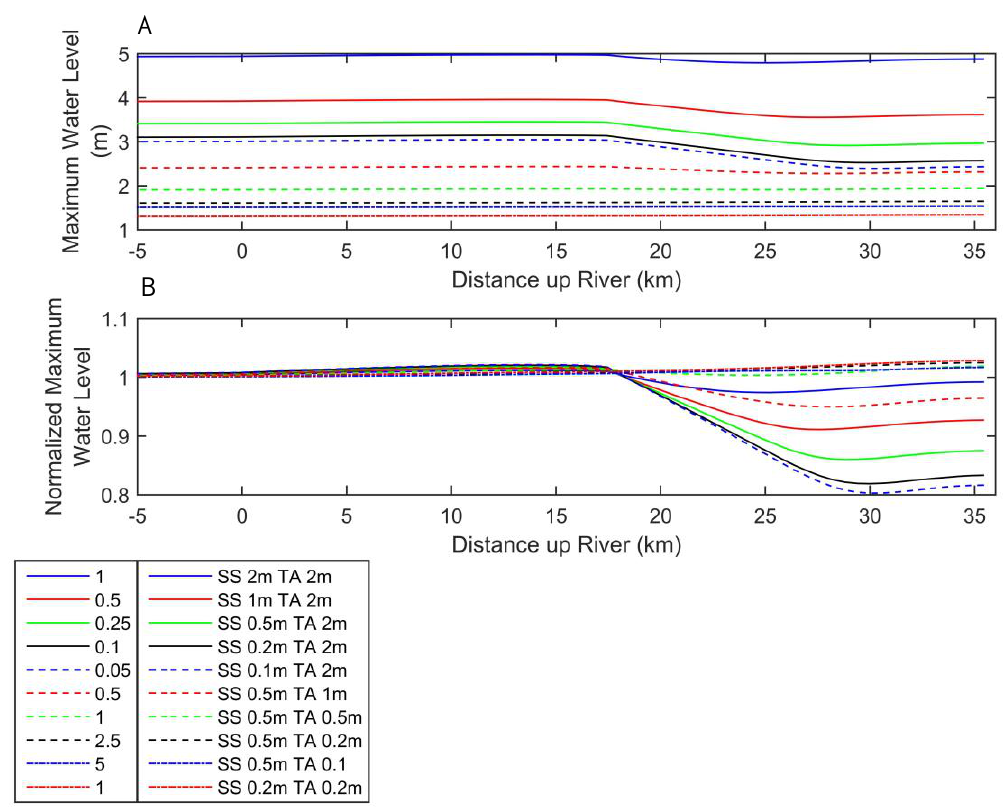
Figure 7. ( A ) Maximum water levels along the idealized river with varying storm surge (SS) and tidal amplitude (TA). The value for each simulation is shown in the legend. ( B ) The water level normalized by the maximum experienced at the open water boundary condition. The lines are the same as in the first figure; however, the legend indicates the ratio of SS to TA.